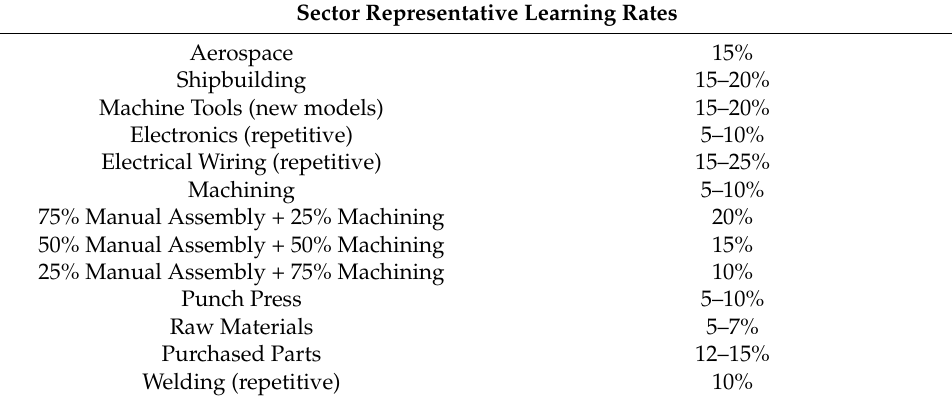
Table 12. Representative learning rates by industrial